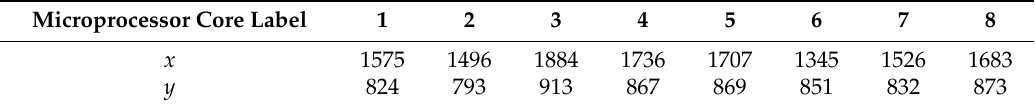
Table 2. The numbers of the operations and the valid instructions.